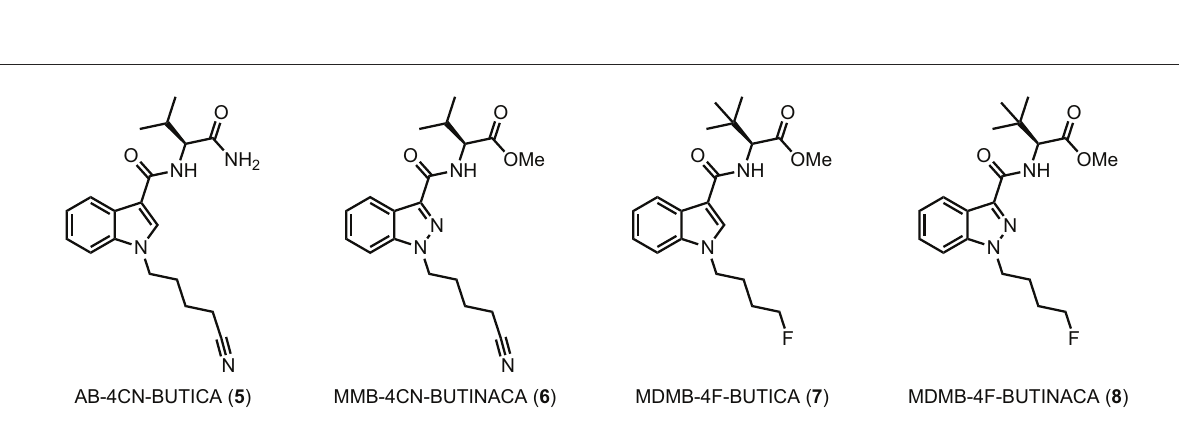
FIGURE2 Detected SCRAs AB-4CN-BUTICA (5) , MMB-4CN-BUTINACA (6) , MDMB-4F-BUTICA (7) , and MDMB-4F-BUTINACA (8)